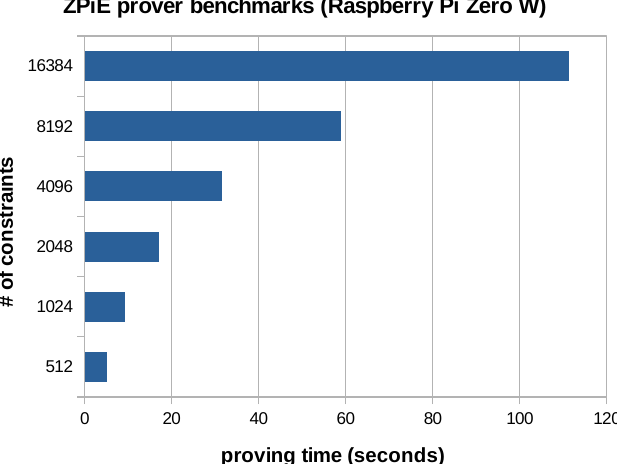
Figure 5. CPUs proving times of ZPiE executed in a Raspberry Pi Zero W. The used zk-SNARK is Groth’16, and the elliptic curve